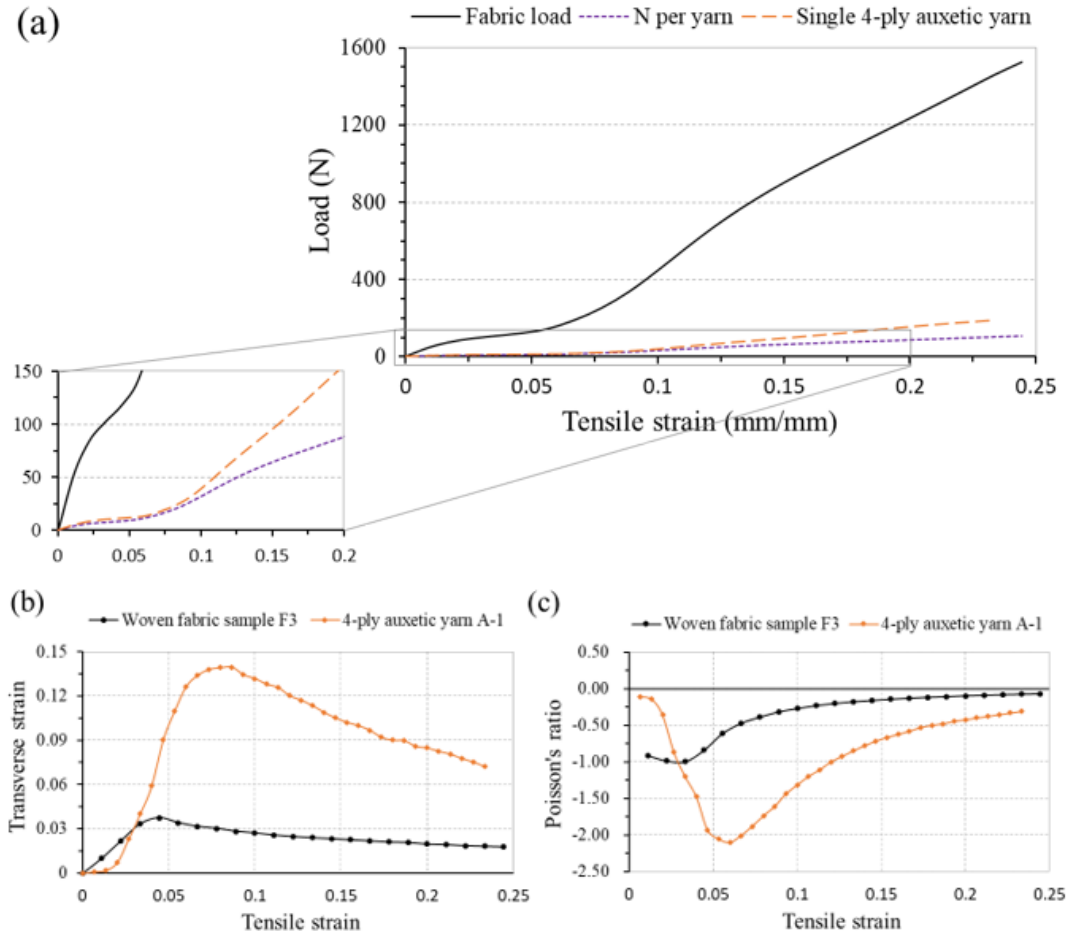
Figure 7. Tensile behavior of a typical auxetic woven fabric and its constituent auxetic yarn: ( a ) load-strain curves (the inset shows the enlargement at small load); ( b ) transverse-tensile strain curves; ( c ) PR-tensile strain curves.